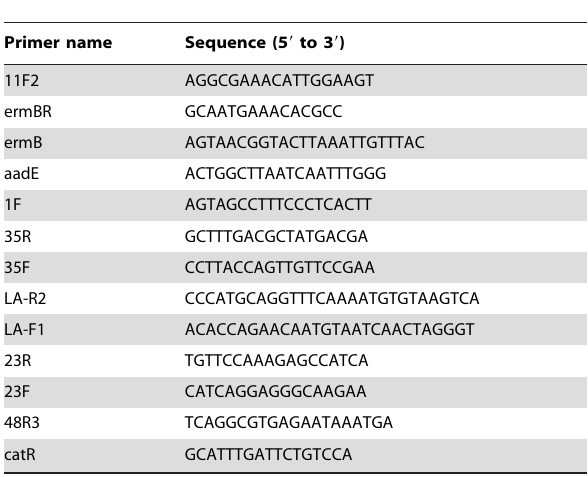
Table 3. Primers used for PCR mapping of the MES PM1